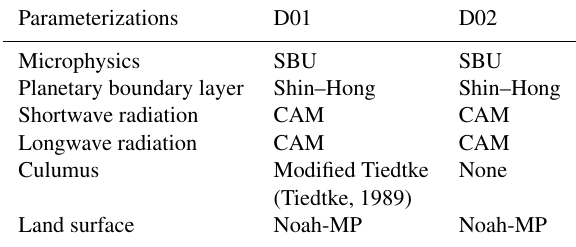
Table 1. List of default parameterization schemes for the simulation of outer domains (D01 and